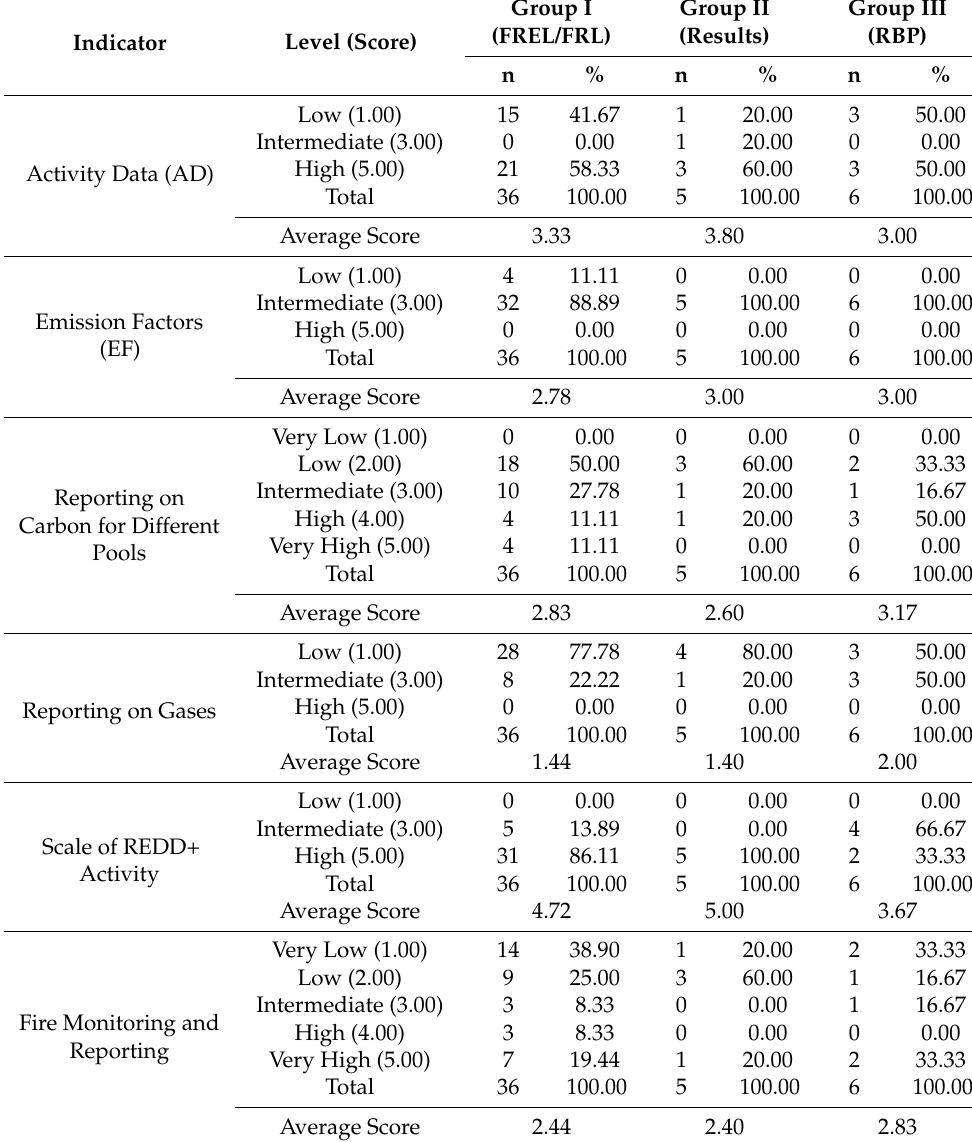
Table 8. Results of MRV capacity evaluation on the